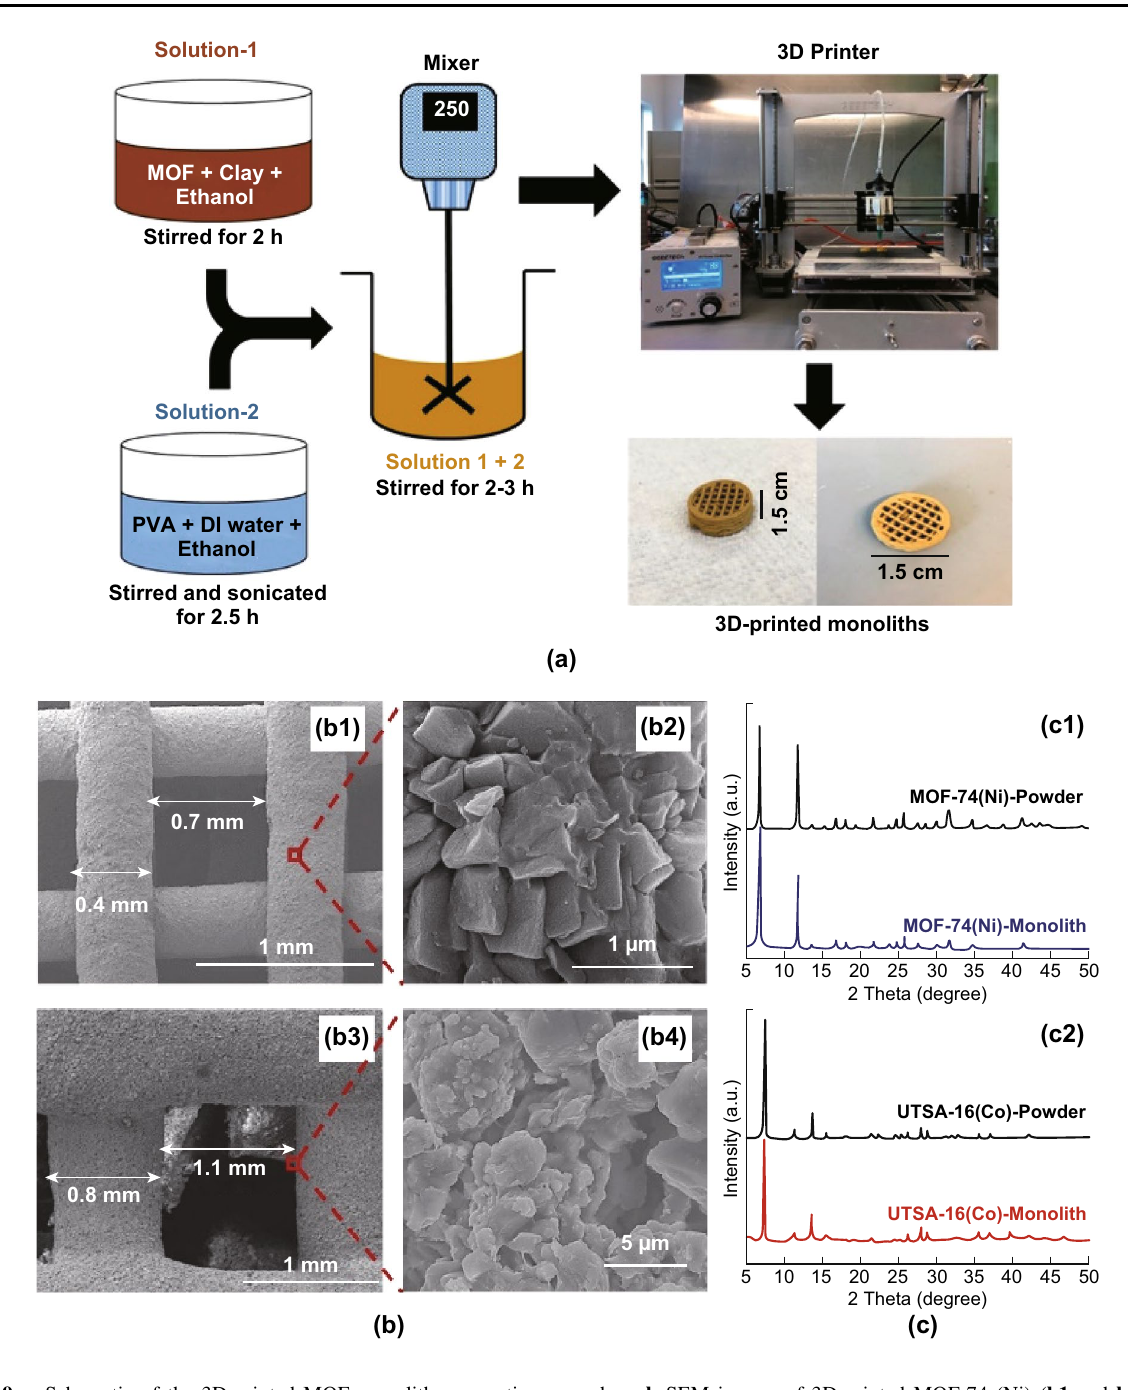
Fig. 19 a Schematic of the 3D-printed MOF monolith preparation procedure. b SEM images of 3D-printed MOF-74 (Ni) ( b1 and b2 ) and 3D-printed UTSA-16 (Co) ( b3 and b4 ), showing uniform distribution of MOF crystals and with large voids. c PXRD patterns of 3D-printed MOF-74 (Ni) ( c1 ) and 3D-printed UTSA-16 (Co) ( c2 ) with their powder counterparts, showing crystallinity retained for both MOF-74 (Ni) and UTSA-16 (Co) MOFs after they were extruded into the monolith form. Reprinted with permission from Ref. [146]. Copyright 2017 American Chemical